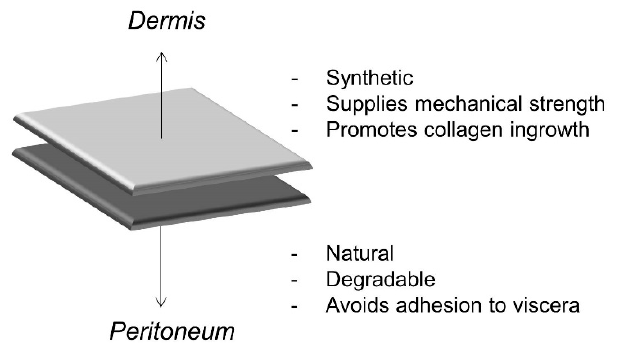
Figure 2. Schematic representation of the structure of composite meshes.